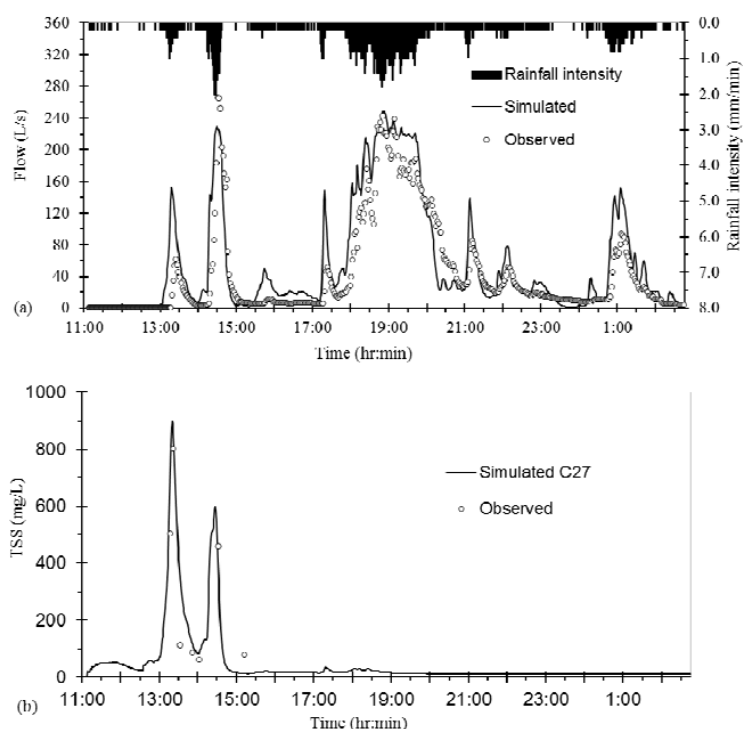
Figure 6. Simulated and observed flow (L/s) ( a ) and TSS concentration (mg/L) ( b ) for the SWMM model calibration on 21 July 2012 including observed rainfall hyetograph.